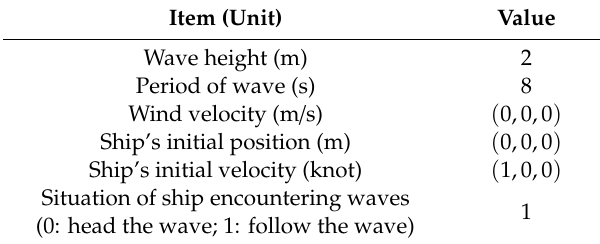
Table 4. Details of initial condition A.